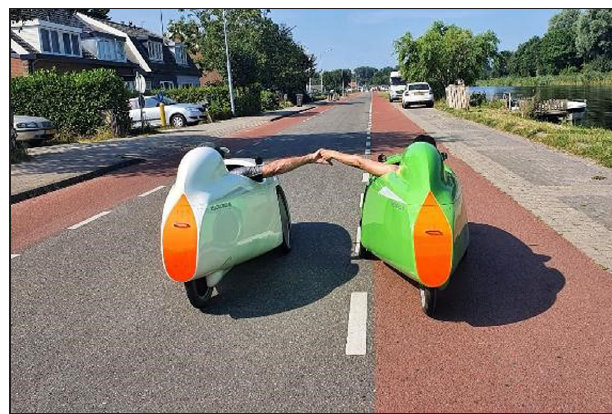
Figure 7: Velomobiles on the